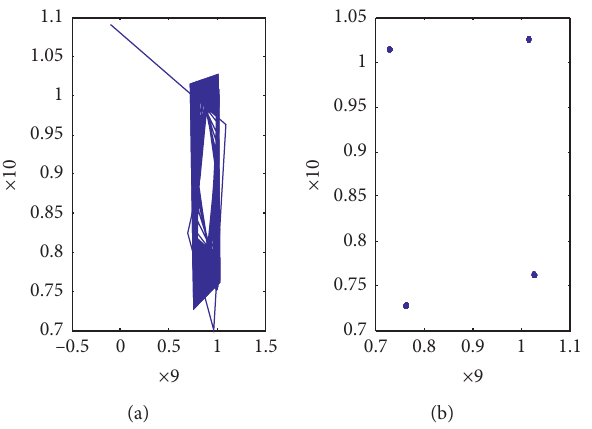
Figure 34: ω � 174 and k when t ∈ 0 . 05 0 . 0597 􏼂